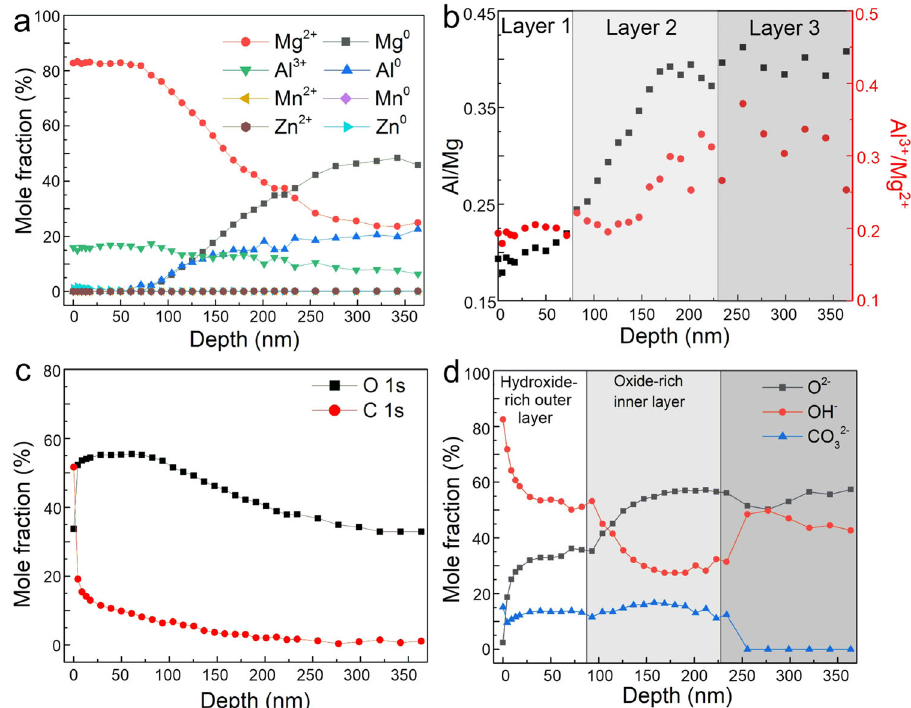
Fig. 5 XPS analysis of elemental distribution of NaCl-immersed surface. a fraction of each cation and elemental metal, b Al/Mg and Al 3 + / Mg 2 + ratio, c fraction of O and C among metallic and non-metallic element, and d fraction among O 2 − , OH − , and C O 2 (cid:1) of